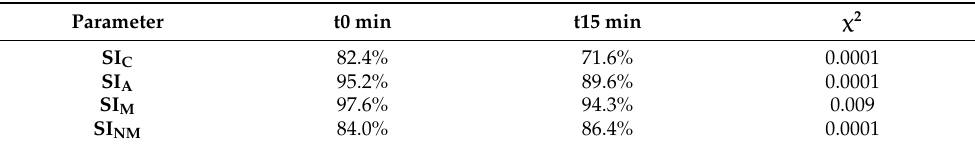
Table 3. Proportion of bilaterally successful AVS with SI cutoff ≥ 2.0.